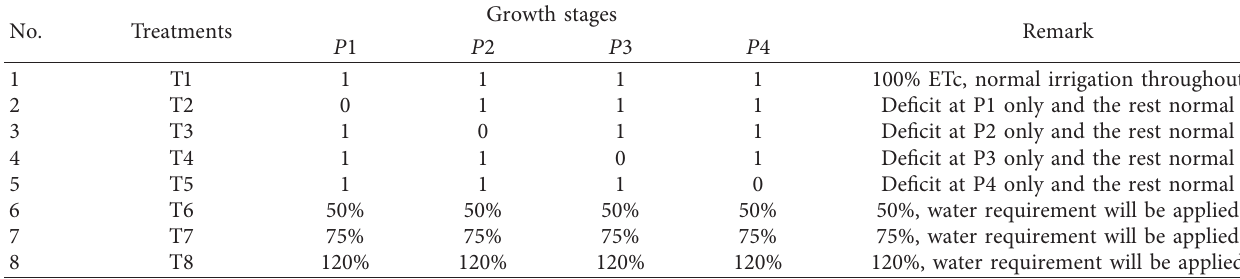
Table 2: Description of irrigation treatments.